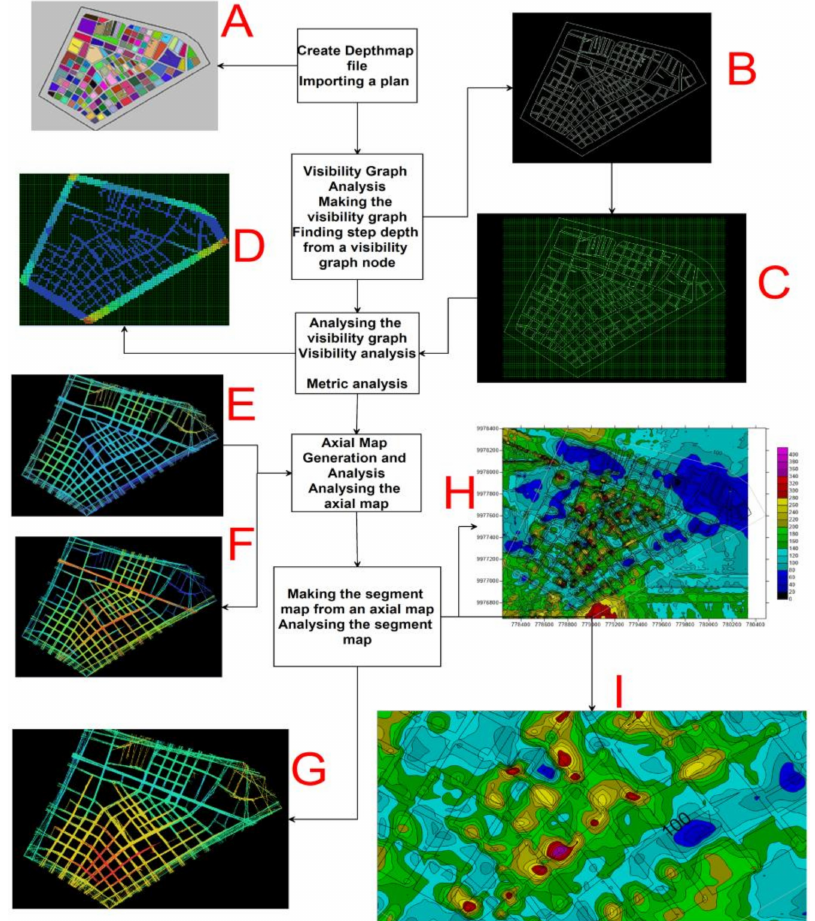
Figure 8. Flow process diagram with DepthmapX used to analyze the spatial relationships of the basic spatial elements, according to the theory of Space Syntax. The description of each process ( A – I ) is described in the